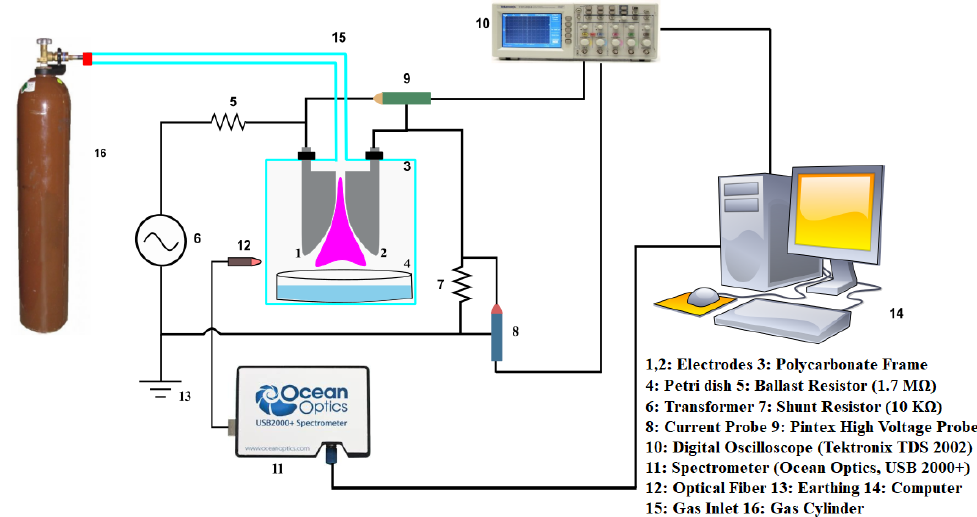
Figure 1. Image of the Experimental setup.